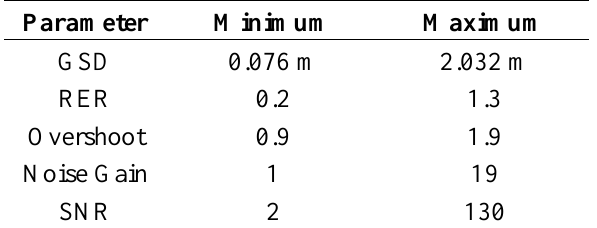
Table 2. Range of values of the general image-quality equation